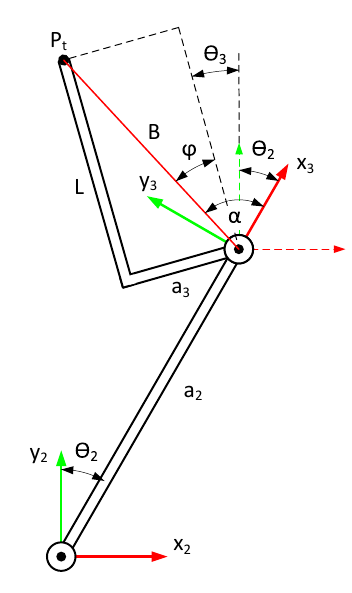
Figure 15: Geometric approach for elbow joint θ 3